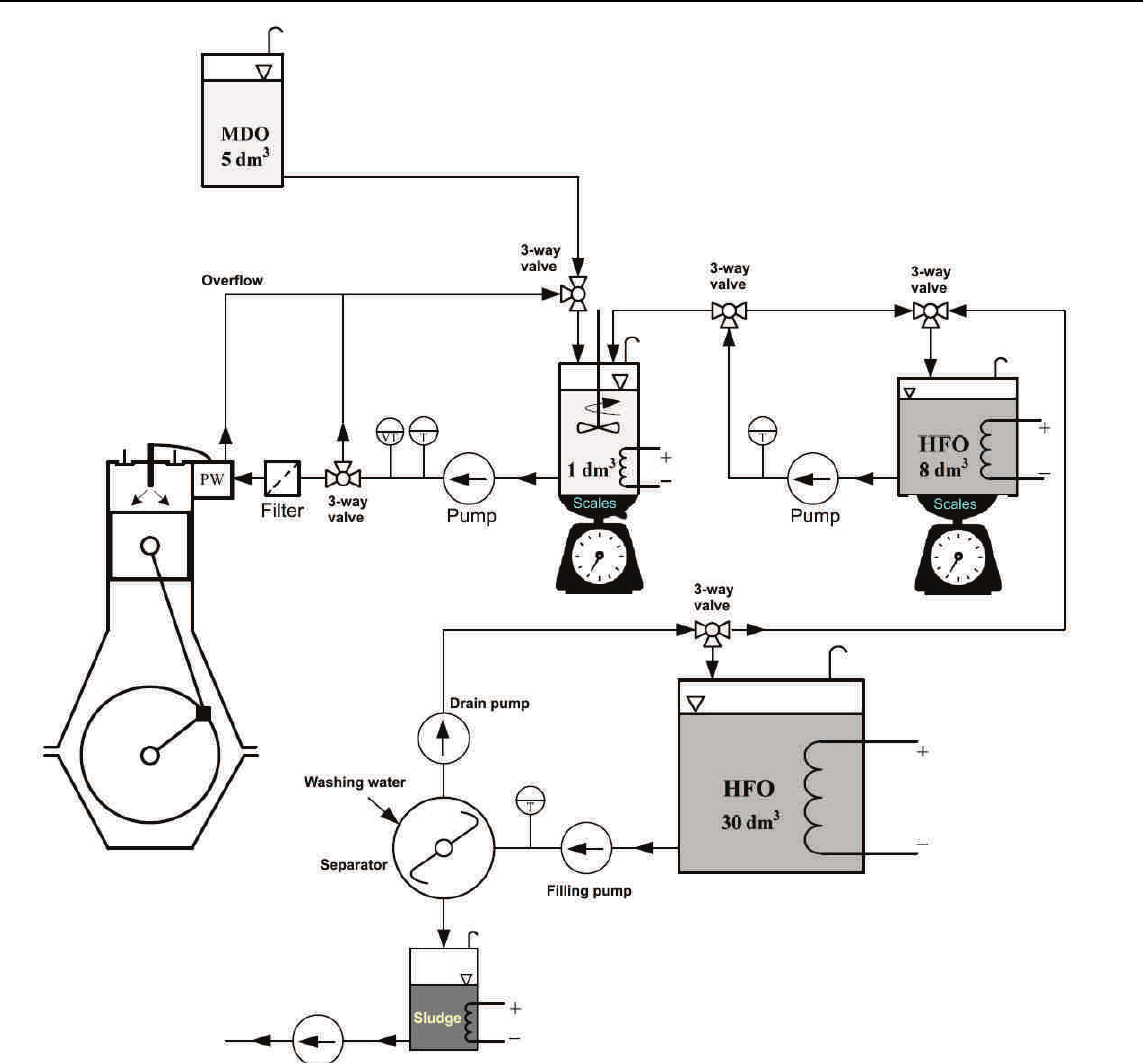
Fig. 2. Conceptual scheme of installation of supplying the laboratory engine Farymann Diesel type D10 with fuel oil: MDO – Marine Diesel Oil; HFO – Heavy Fuel Oil; PW – injection pump, VT – viscometer, T –